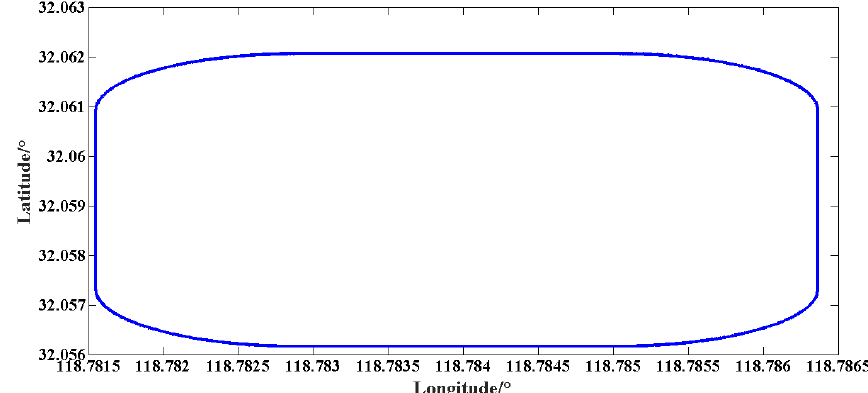
Figure 6. Circular maneuver path.